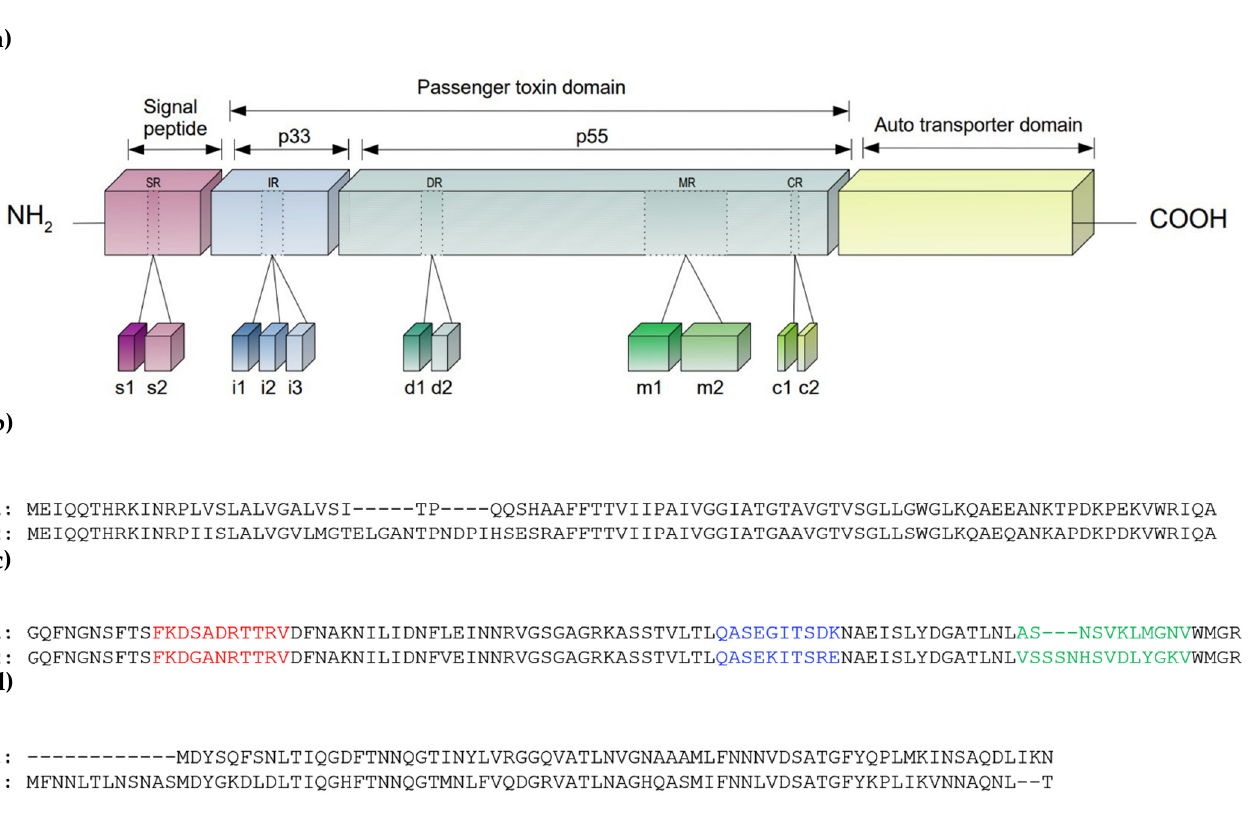
Figure 2. Schematic representation of the VacA protein and its variable regions. The different domains of the virulence factor are highlighted ( a ). Variable regions s (signal), i (intermediate), d (delete), m (medium) and c (c-regions) are represented along with their known variants. Based on Soyfoo et al., 2021 [56]. The amino acid residues of the main variable regions of VacA protein used for typing purposes are depicted ( b – d ). Sequence alignment of s1 and s2 regions (translated from sequence accession numbers LC187397 and LC187396, respectively) evidencing shorter s1 region ( b ); partial sequence alignment of i1 and i2 regions (translated from sequence accession numbers LC187485 and LC187502, respectively), evidencing cluster A (red), B (blue) and C (green). i1 and i2 classification is made based on sequence similarity with clusters B and C. Sequences displaying discordant pairing of the clusters B and C (one cluster i1 type and another i2 type) are classified as i3 ( c ), and sequence alignment of m1 and m2 regions (translated from sequence accession numbers EU551739 and EU551740, respectively) evidencing shorter m1 region ( d ). VacA s2 toxins are produced and secreted at lower rates and are unable to form the membrane channels through which VacA s1 induces vacuolation of cells; therefore, the VacA s2 variant is considered less pathogenic than the s1 [19]. VacA i1 is also linked with increased vacuolating activity compared to VacA i2. VacA m1 induces a decrease